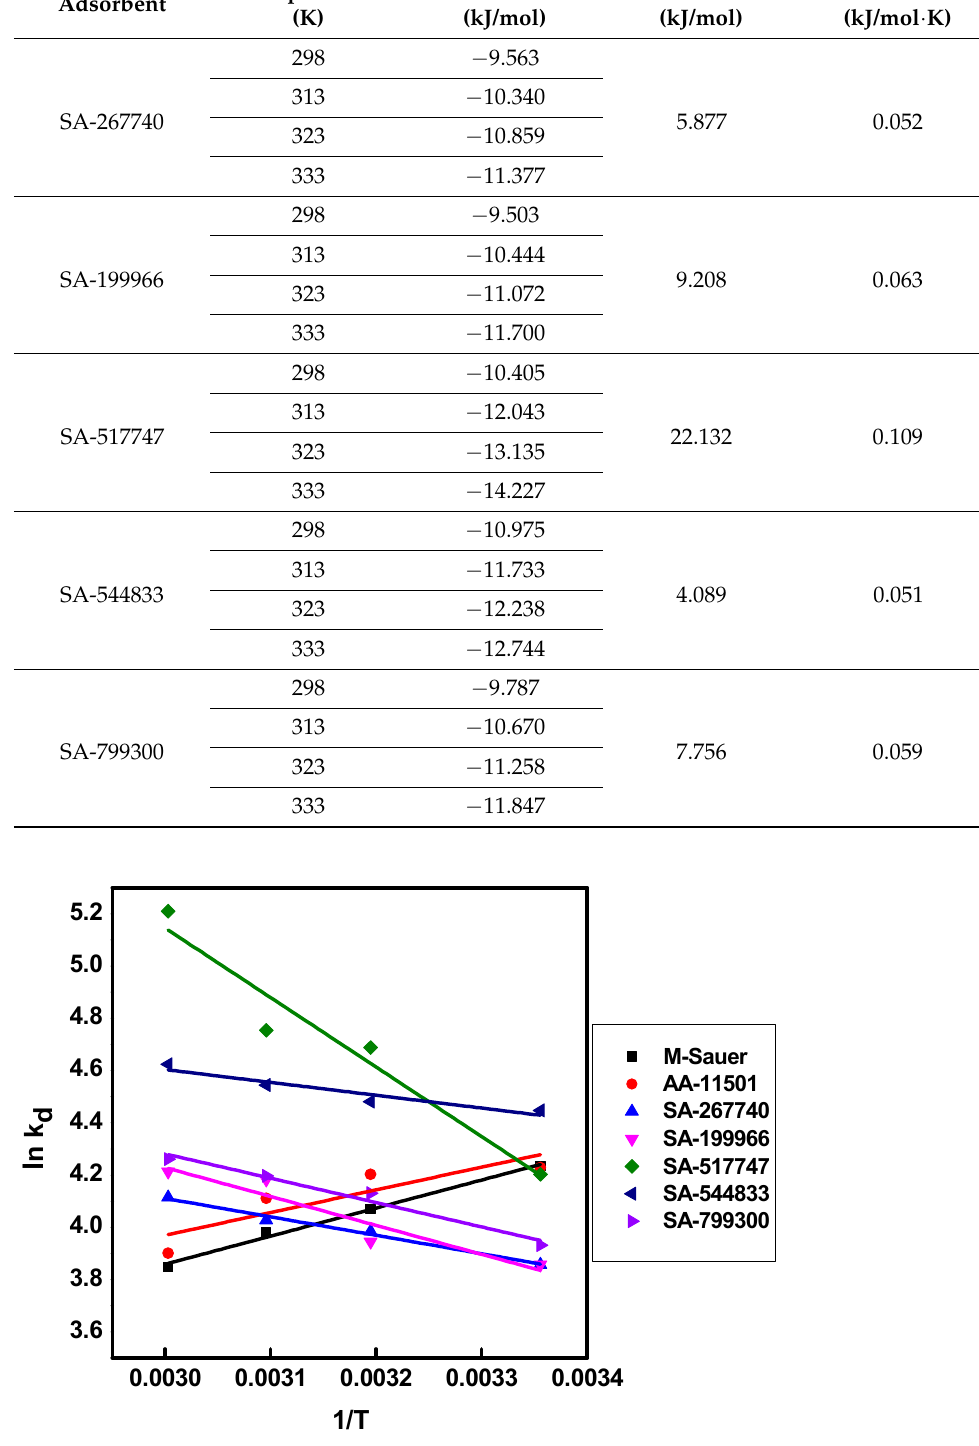
Figure 2. Van’t Hoff plot for the sorption of CA- 99 Mo on different alumina adsorbents.